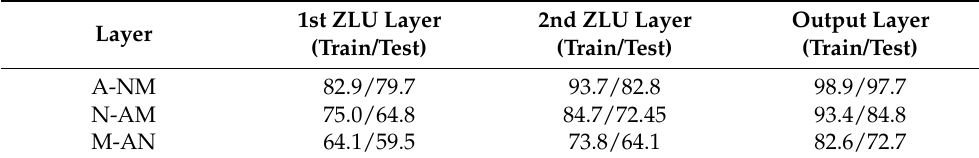
Table 3. Accuracies by layers of ZNN for three AD assessments (%).